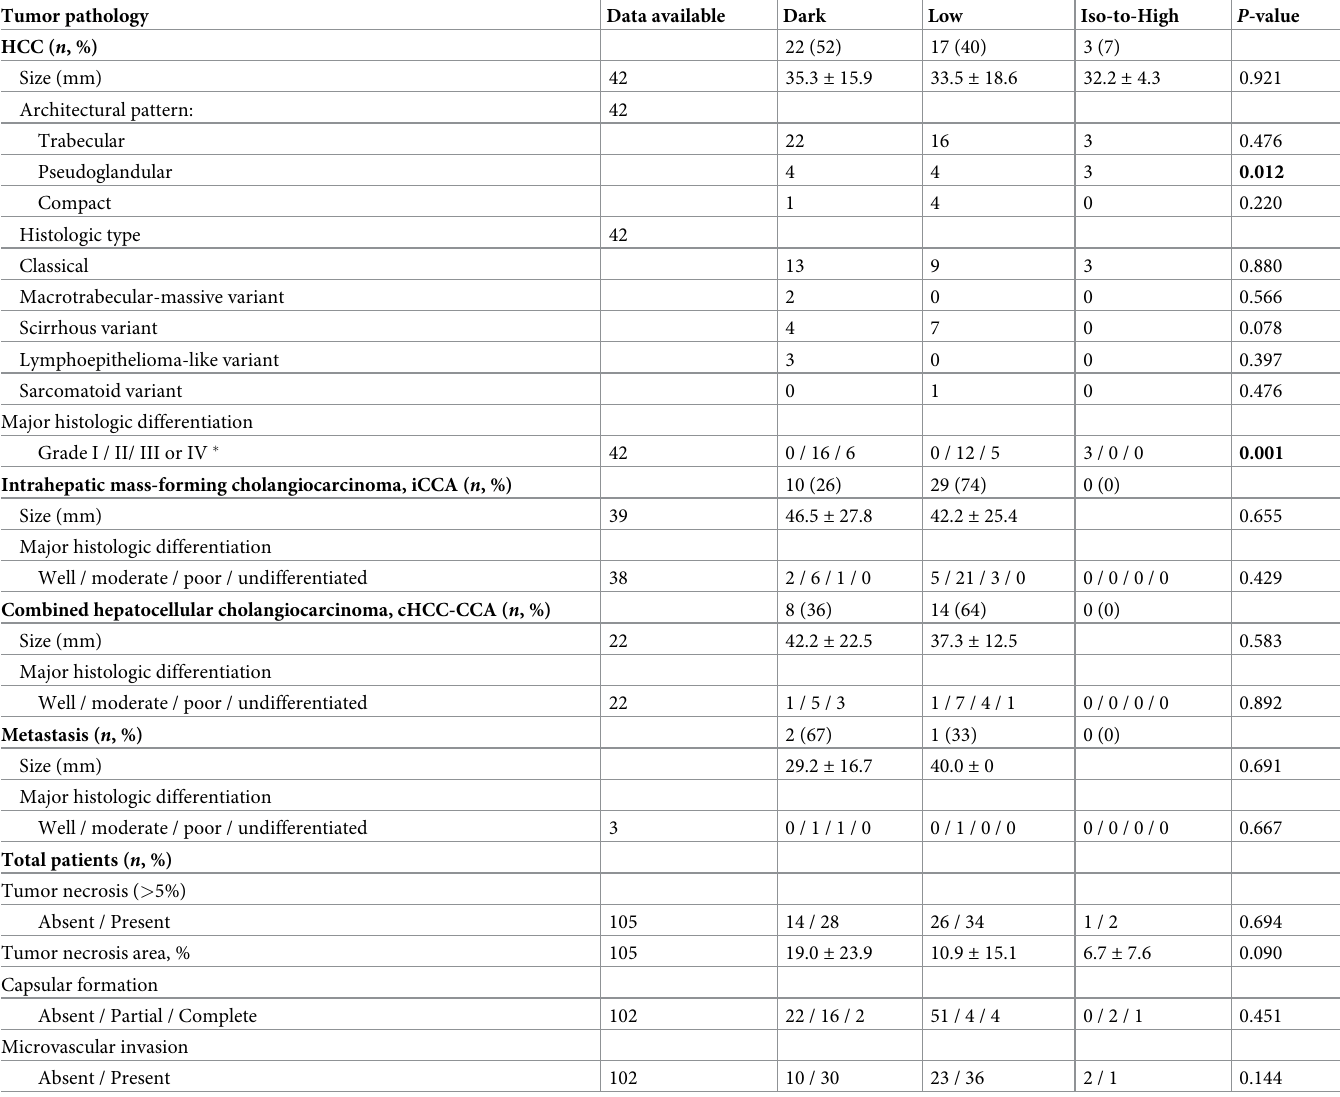
Table 4. Histopathologic characteristics of malignancies based on HBP signal